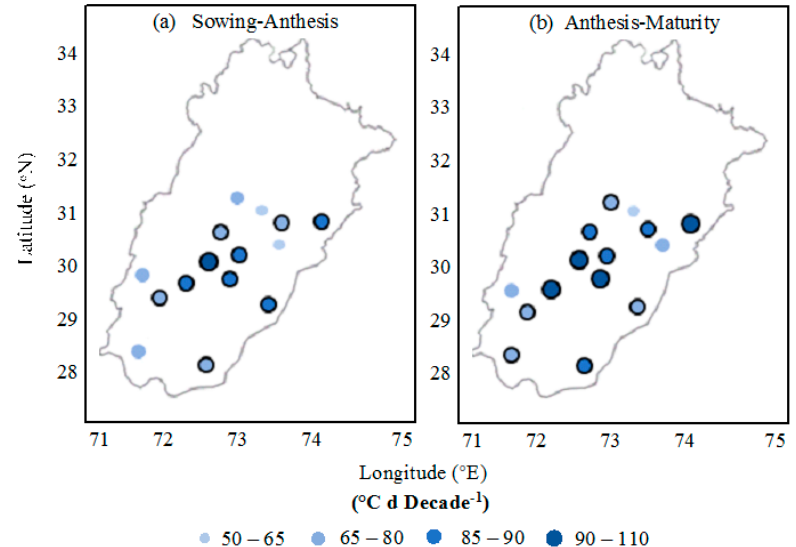
Figure 6. Observed trends in thermal time required for cotton in Punjab, Pakistan, to advance from ( a ) sowing − anthesis and ( b ) anthesis − maturity. Circles with black border indicate statistically significant trend at p = 0.05 probability level.